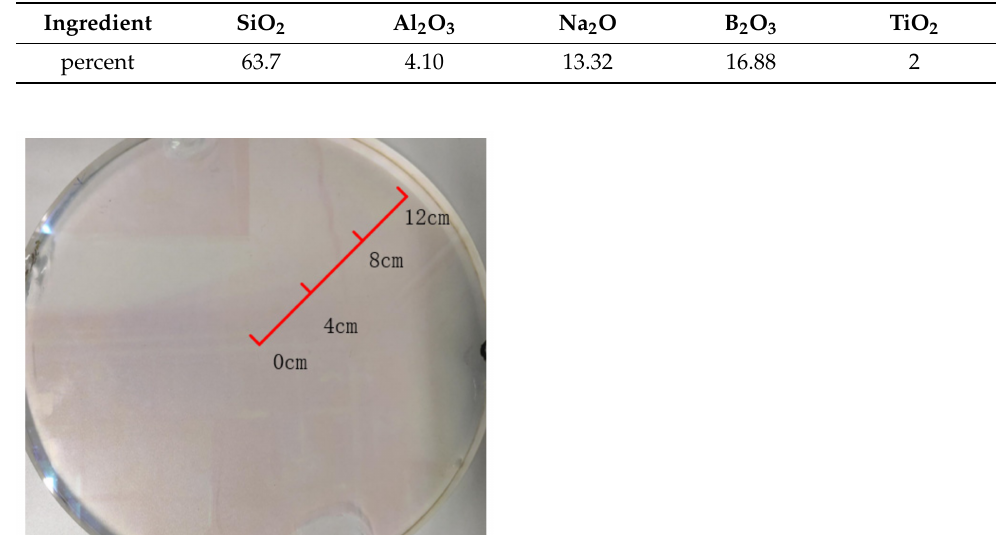
Figure 1. EAST Thomson scattering diagnostic optical system of Laser transmission light path. Table 2. Tokamak lower window glass compositionol%.